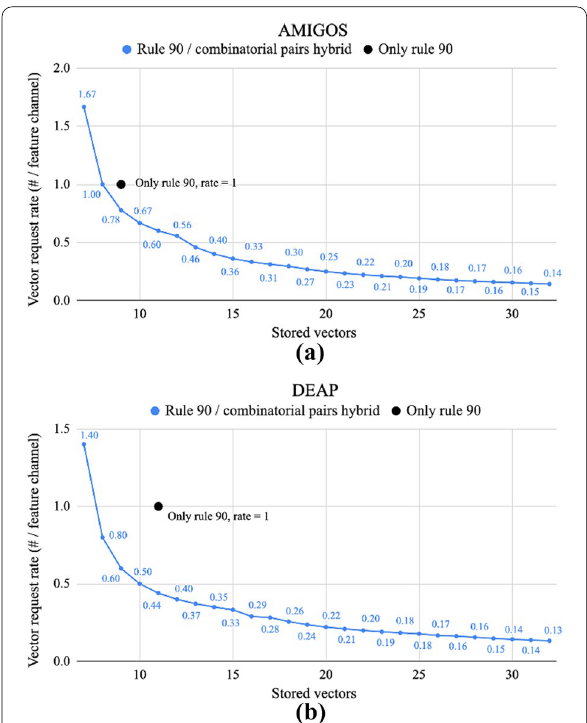
Fig. 8 Vector request rate (number of vectors requested per input channel) as the number of vectors stored increases while using rule 90 on a small set of continuously re-populating vectors as compared to only rule 90 for a AMIGOS and b DEAP